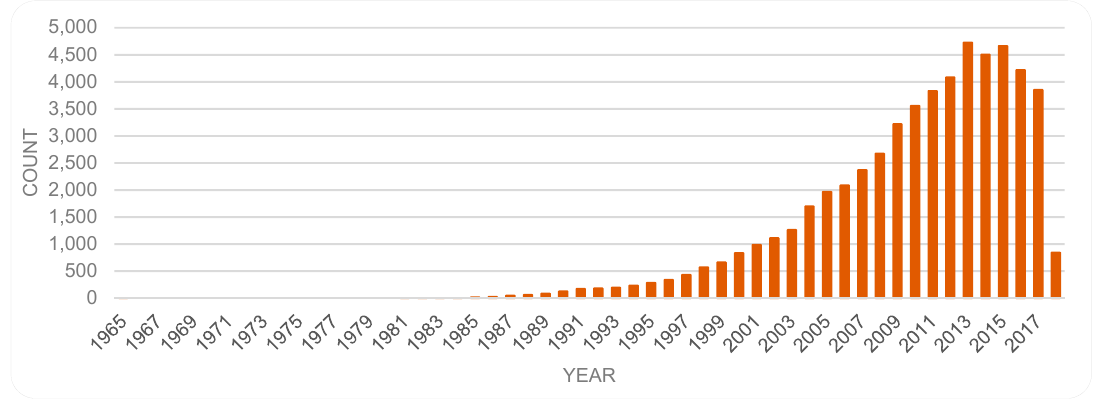
Figure 1. Yearly number of publications on biosensors based on the PubMed dataset.